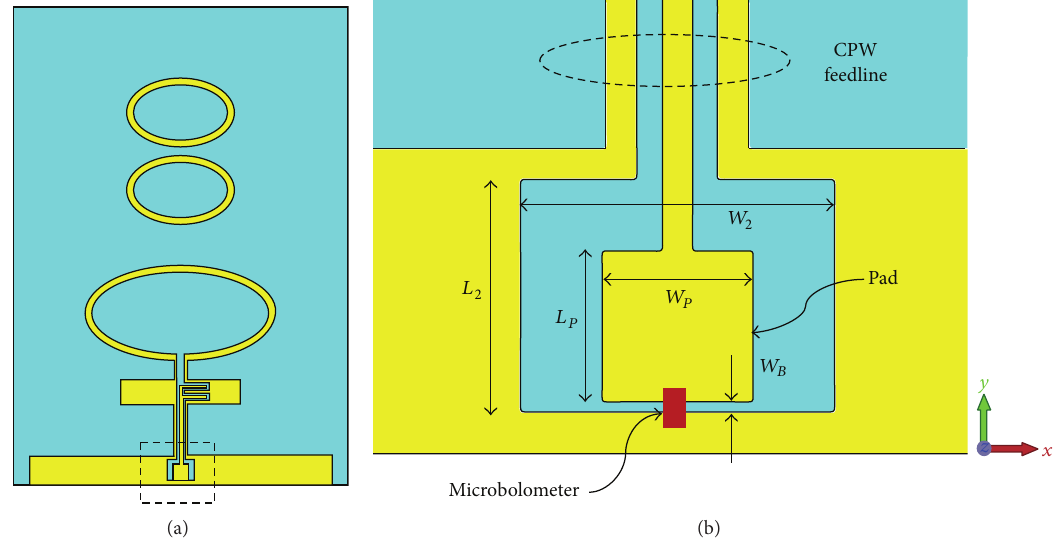
Figure 3: Geometrical configuration of the proposed Quasi-Yagi loop antenna prototype I with added microbolometer for radiation pattern measurements: (a) top view and (b) detailed view for